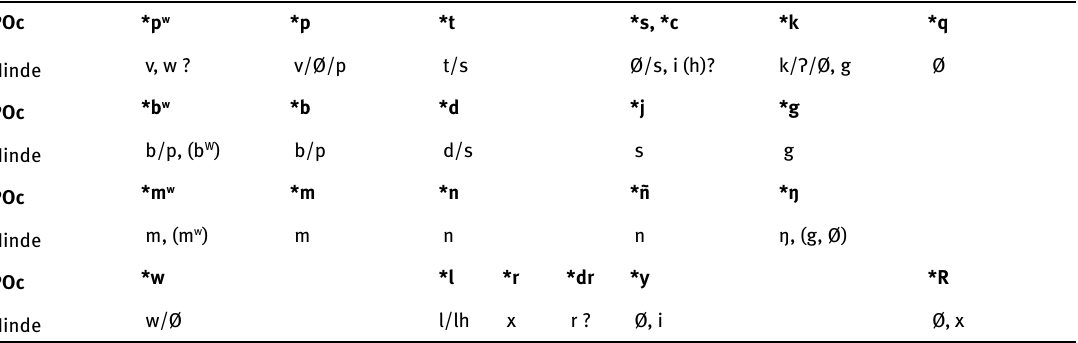
Table 3: Ninde reflexes of POc